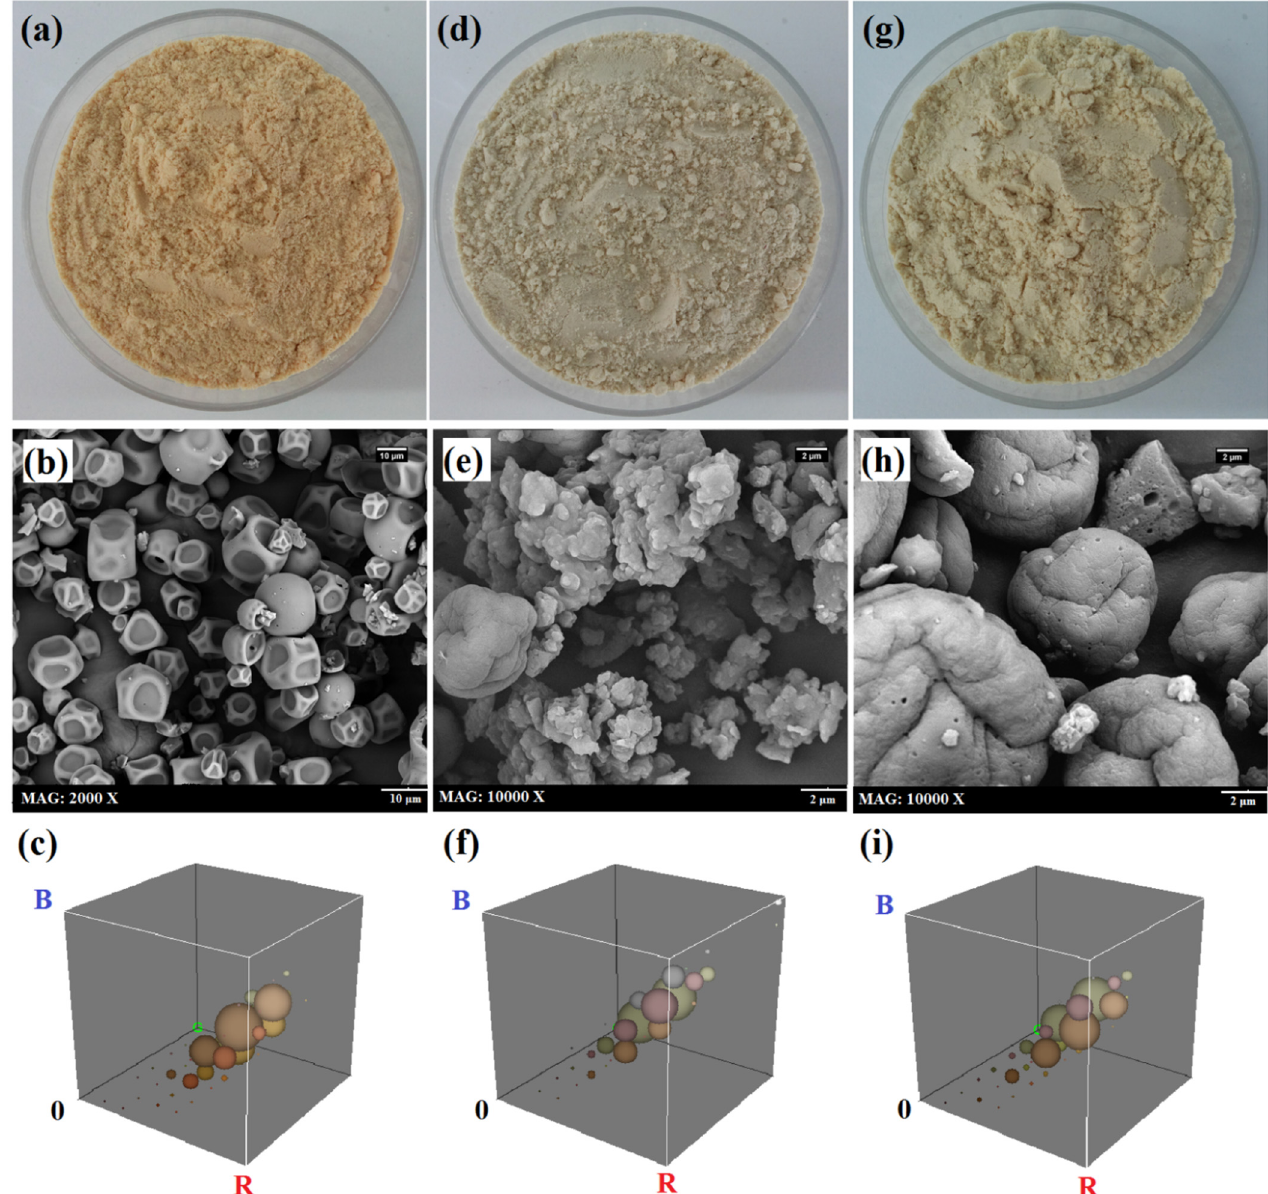
Figure 5. Optical and SEM images, and RGB plots related to spray-dried grape seed oil emulsions